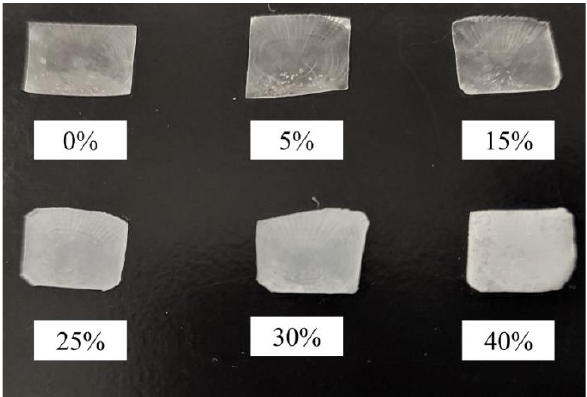
Figure 4. HAp-collagen composite films for each HAp weight ratio.